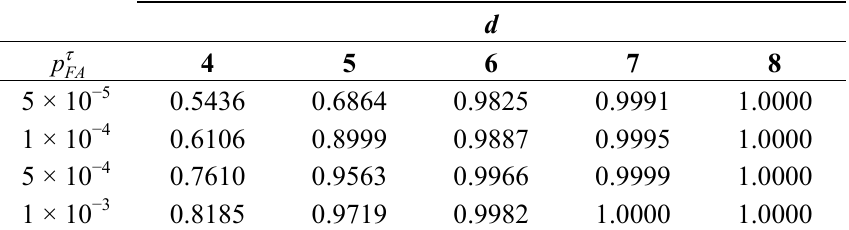
Table 1. under different SNR and